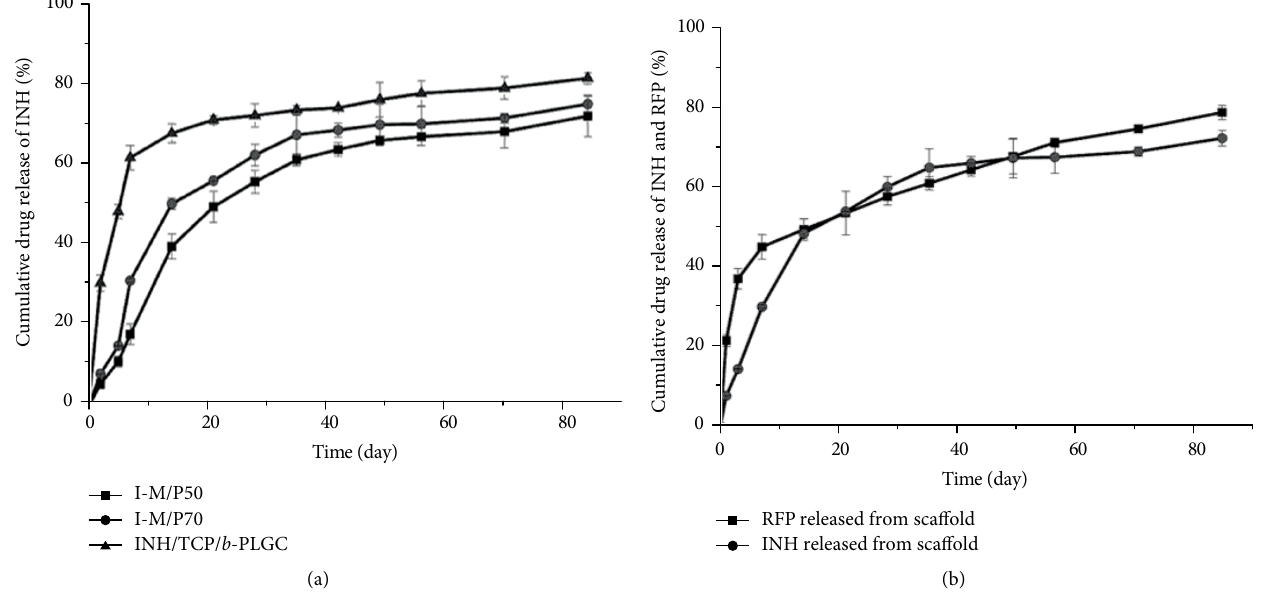
Figure 9: (a) Release behaviours of INH-loaded scaffolds in vitro . (b) INH and RFP Release behaviors of I-M/RP50 scaffolds in vitro